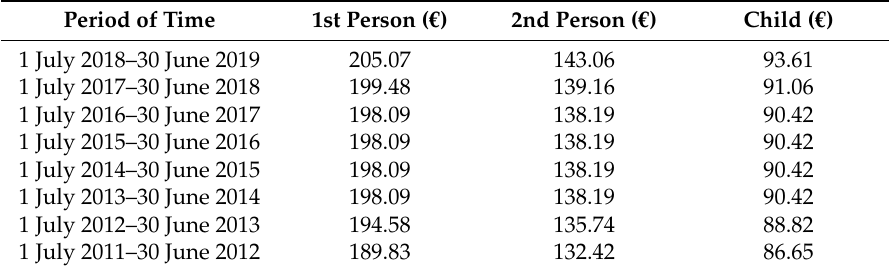
Table 3. Overview of the development of the subsistence minimum in the Slovak Republic. Period of Time 1st Person ( € ) 2nd Person ( € ) Child ( €